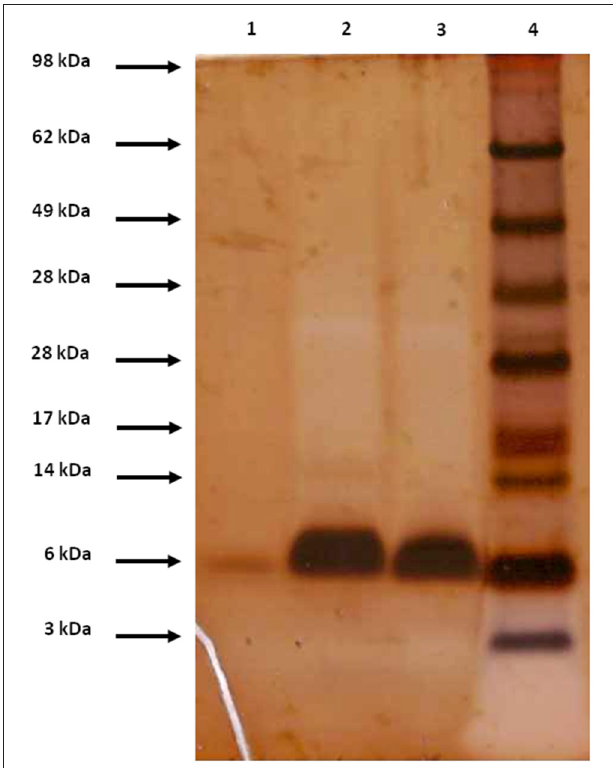
FIGURE 1 | Appearance of nNFAP2, rNFAP2, and sNFAP2 in 4-12% (w/v) Bis-Tris sodium dodecyl sulfate-polyacrylamide gel (NuPAGE TM Novex TM 4–12% Bis-Tris Protein Gels, 1.5mm, 10-well; Thermo Fisher Scientific, Waltham, MA, USA) in 1 × NuPAGE TM MES running buffer (Thermo Fisher Scientific, Waltham, MA, USA). Protein bands are visualized applying silver staining. Lane 1: nNFAP2 (2 µ g), lane 2: rNFAP2 (10 µ g), lane 3: sNFAP2 (10 µ g), lane 4: SeeBlue TM Plus2 Pre-stained Protein Standard (Thermo Fisher Scientific, Waltham, MA, USA). nNFAP2: native NFAP2 produced by N. fischeri NRRL 181, rNFAP2: recombinant NFAP2 produced by P. chrysogenum nfap2 , sNFAP2: synthetic